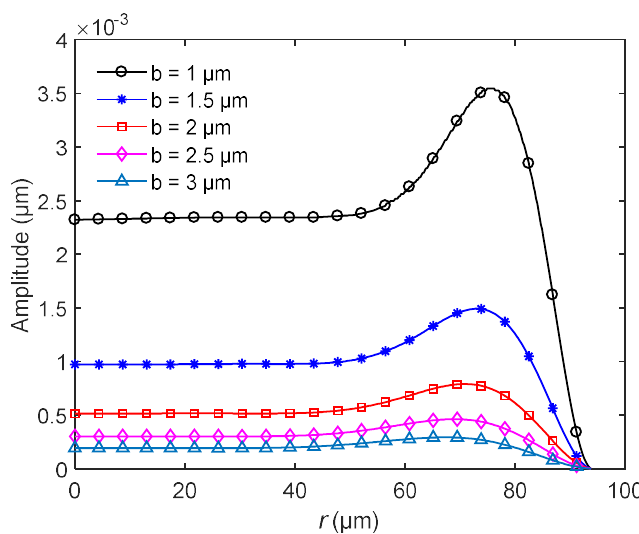
Figure 8. The amplitude distribution of the bionic structure for different thicknesses b .